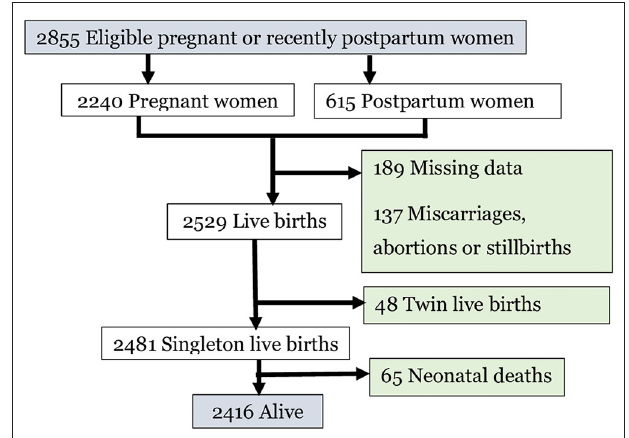
FIGURE 1 | Pregnant or recently postpartum women enrolled, pregnancy outcomes and retained participants for analysis,